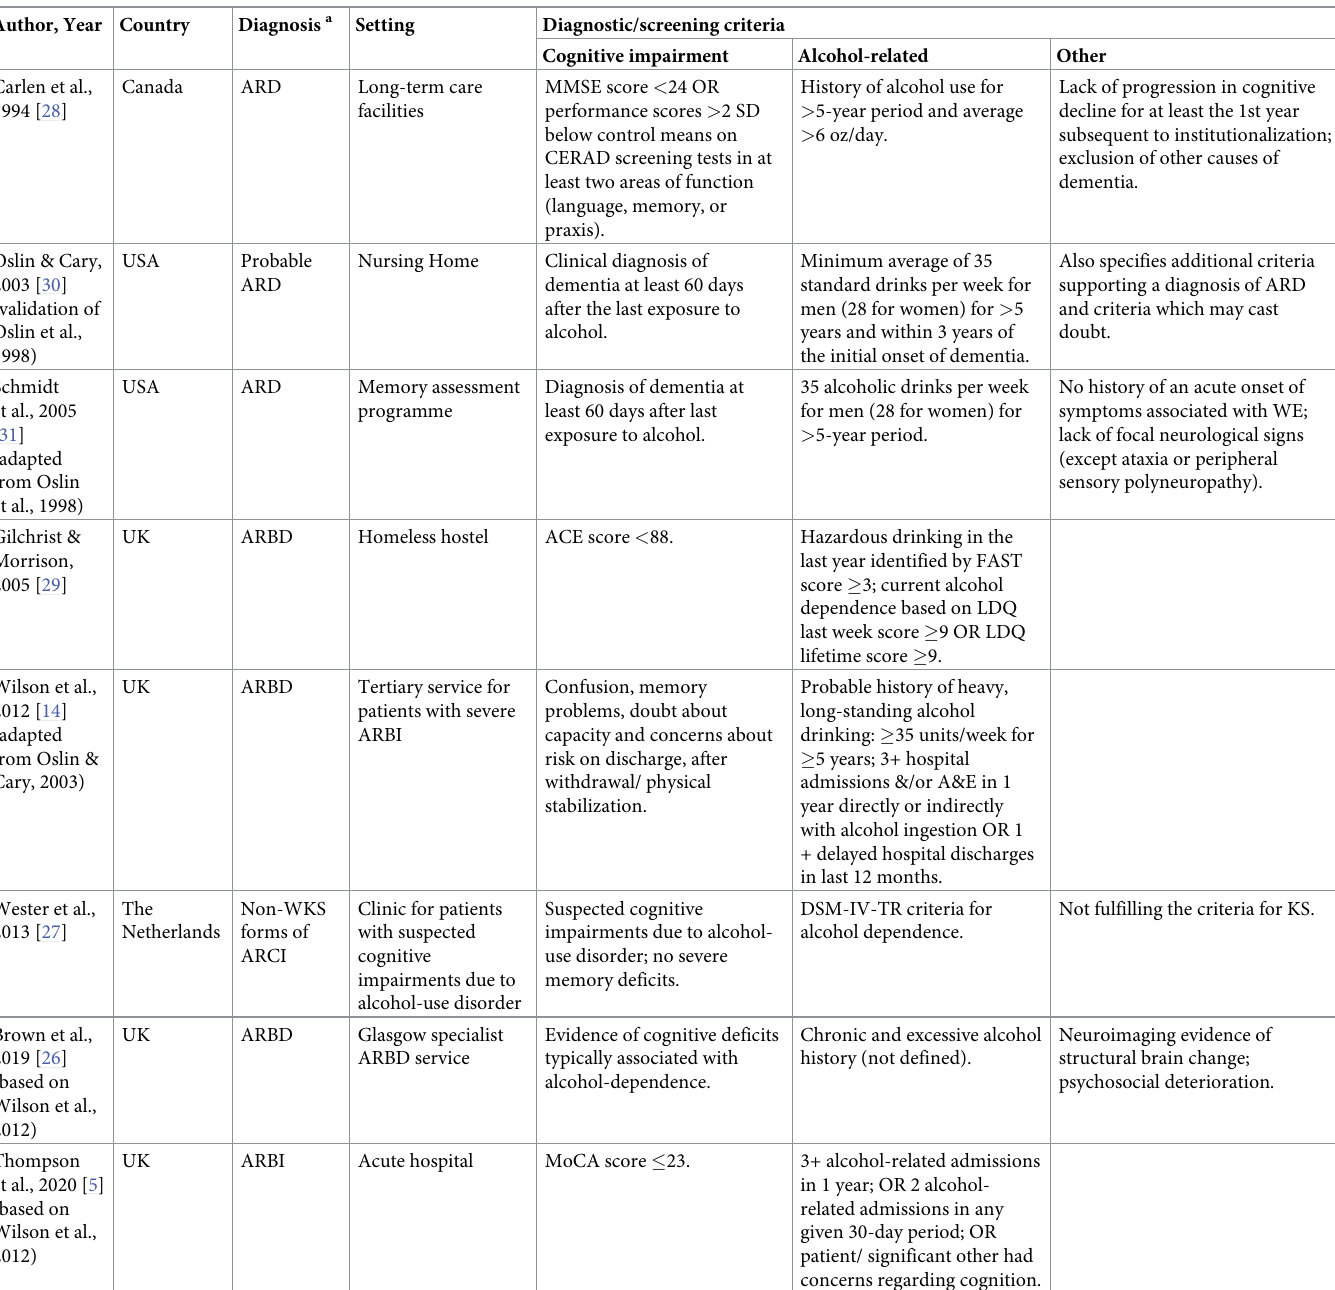
Table 2. Summary of reported diagnostic criteria for